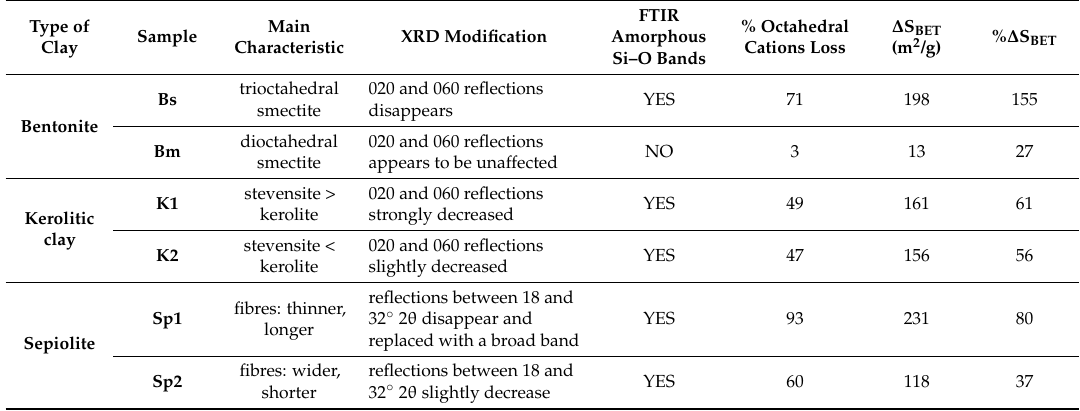
Table 3. Principal modifications obtained after 16 min of microwave-assisted acid treatment